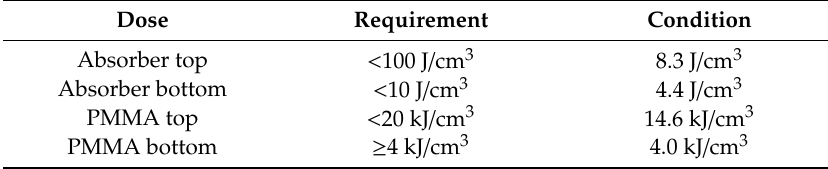
Figure 1. Overall process of hard X-ray lithography and beam source analysis. ( a ) Schematic process of X-ray irradiation into poly (methyl methacrylate) (PMMA) through X-ray mask; ( b ) Comparison of X-ray transmission for each material; ( c ) Analysis of photon flux distribution. Table 3. The dose conditions used in this